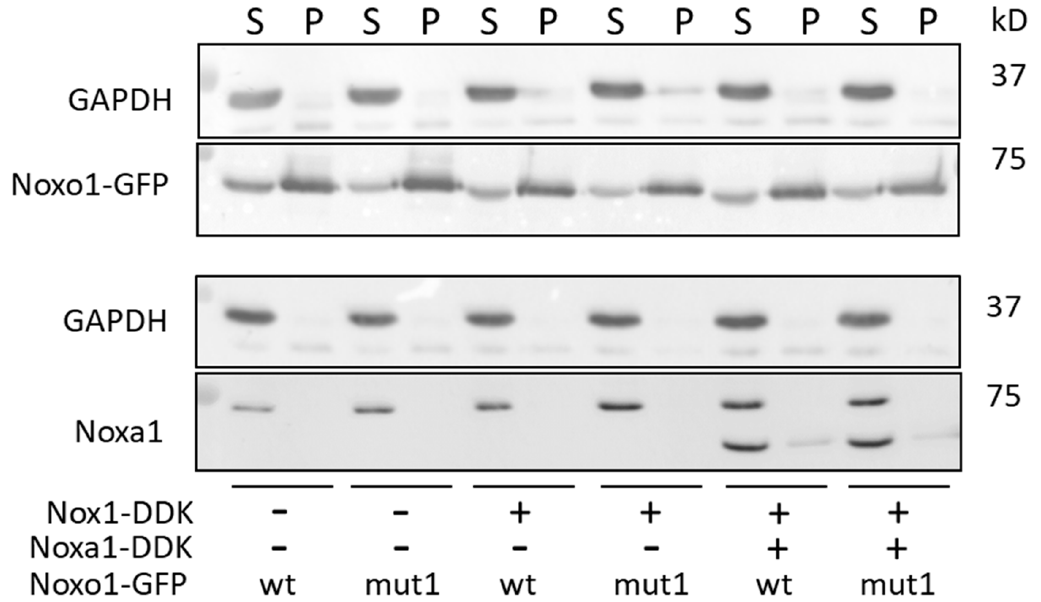
Figure 8. Effect of the expression of NADPH oxidase complex on the distribution of Noxo1-GFP in soluble and insoluble HEK293 cells fractions lysed in RIPA buffer. HEK 293 cells were transfected with wt Noxo1 or mut1 Noxo1 and, Noxa1, Nox1. The result of the expression of these proteins was analyzed by immunoblot using an anti-Noxa1 antibody for Noxa1, an anti-GFP antibody for Noxo1, and an anti-GAPDH antibody for GAPDH. Both wt Noxo1-GFP or mut1 Noxo1-GFP are mainly present in the insoluble fraction (pellet), and to a lesser extent, in the soluble fraction (supernatant). This distribution is independent of whether Nox1 and Noxa1 are expressed endogenously or not. Noxa1 protein is observed almost exclusively in the soluble fraction of RIPA buffer. GAPDH is also mainly present in the supernatant in all conditions and used as the loading